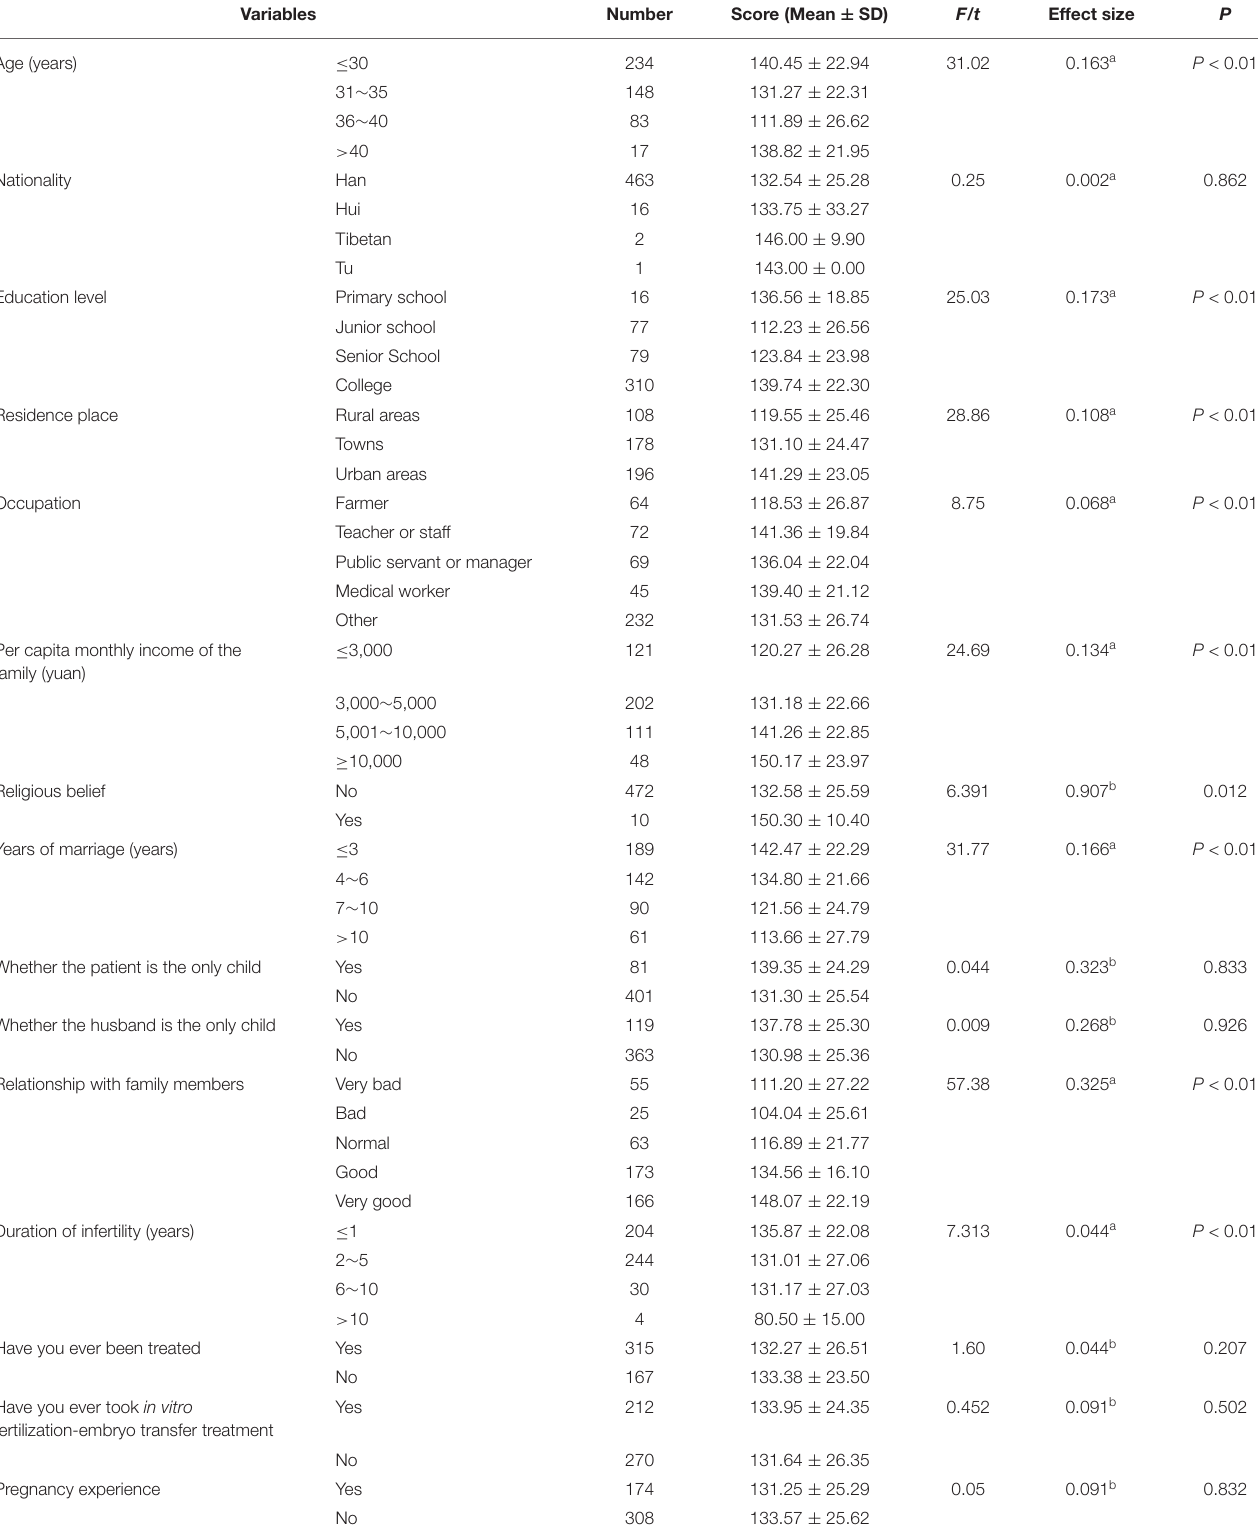
TABLE 1 | Univariate analysis of dyadic coping score of infertile women ( n = 482). Variables